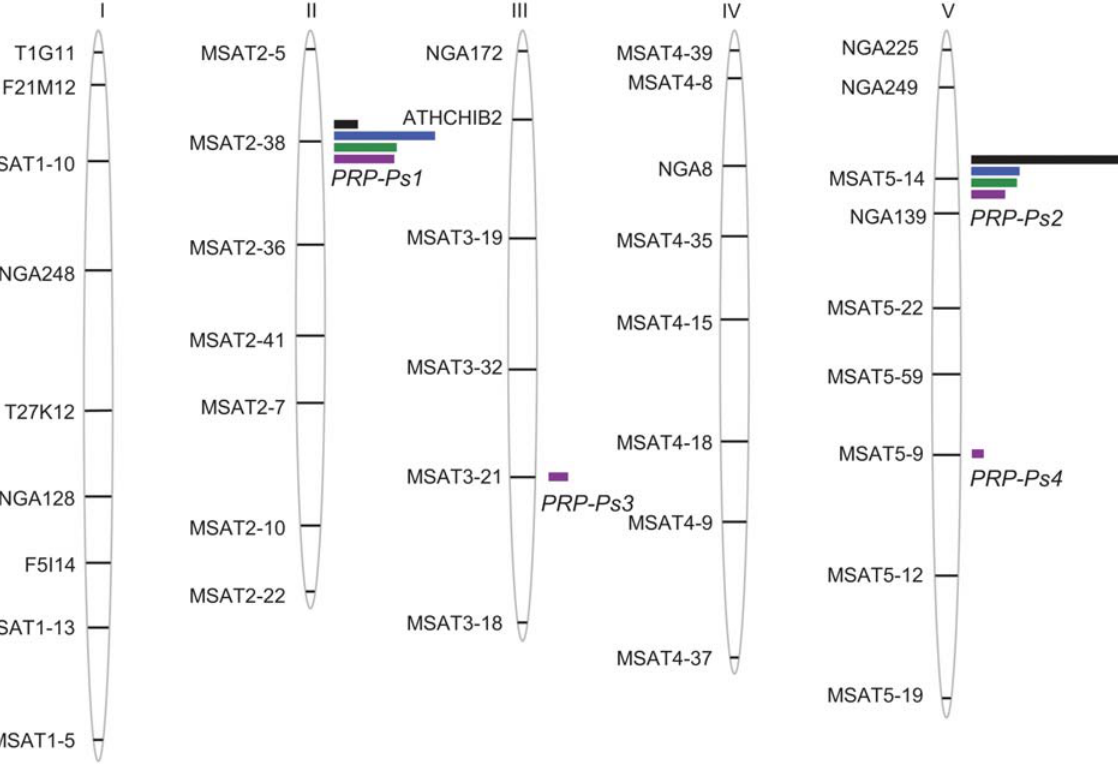
Figure 3. Arabidopsis QTLs controlling partial resistance to Pseudomonas syringae pv. tomato DC3000 in the Bay-0 6 Shahdara recombinant inbred line population. The detected QTLs are represented by bars located at the closest marker position (black, experiment 1; blue, experiment 2; green, experiment 3; purple, experiment 4) on the Bay-0 6 Shahdara genetic map [34]. The length of the bar is proportional to the QTL effect (R 2